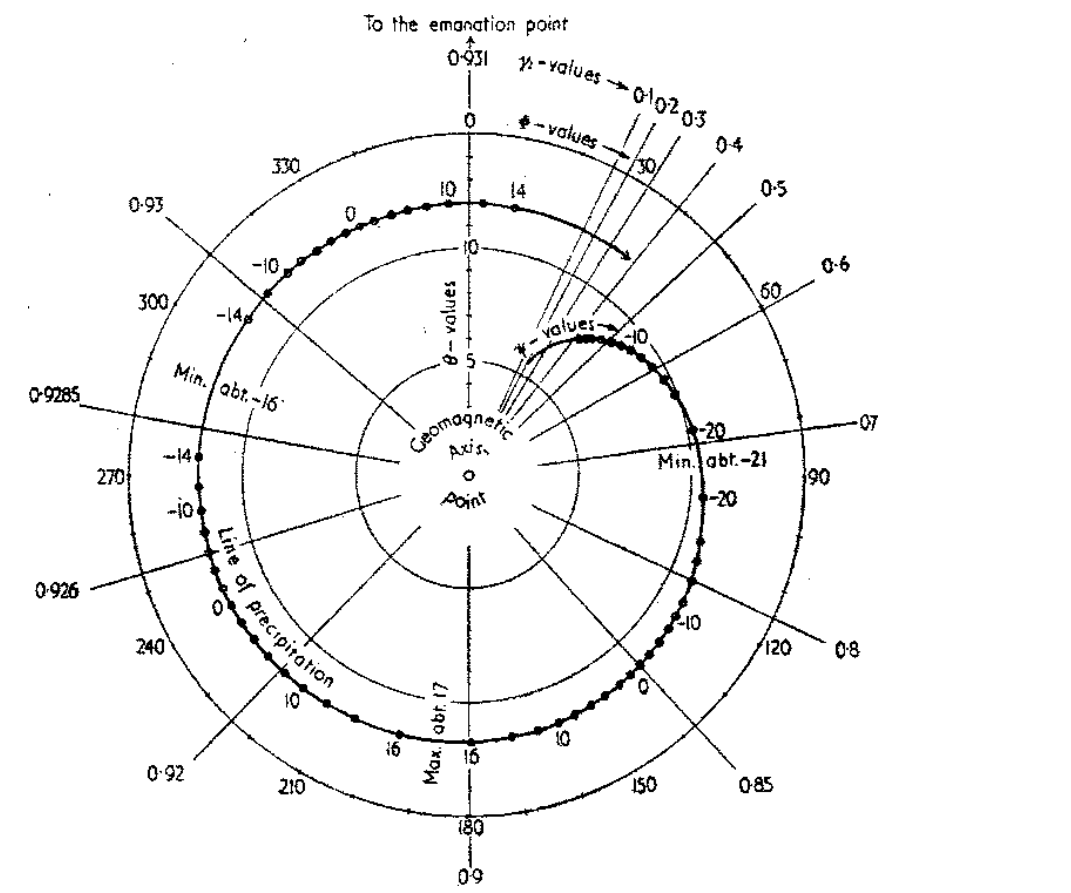
Figure 1. Spiral of positive corpuscles’ precipitation around the magnetic axis. Here, γ stands for a constant of integration and Ψ is the declination of the sun (Størmer, 1955, Fig.